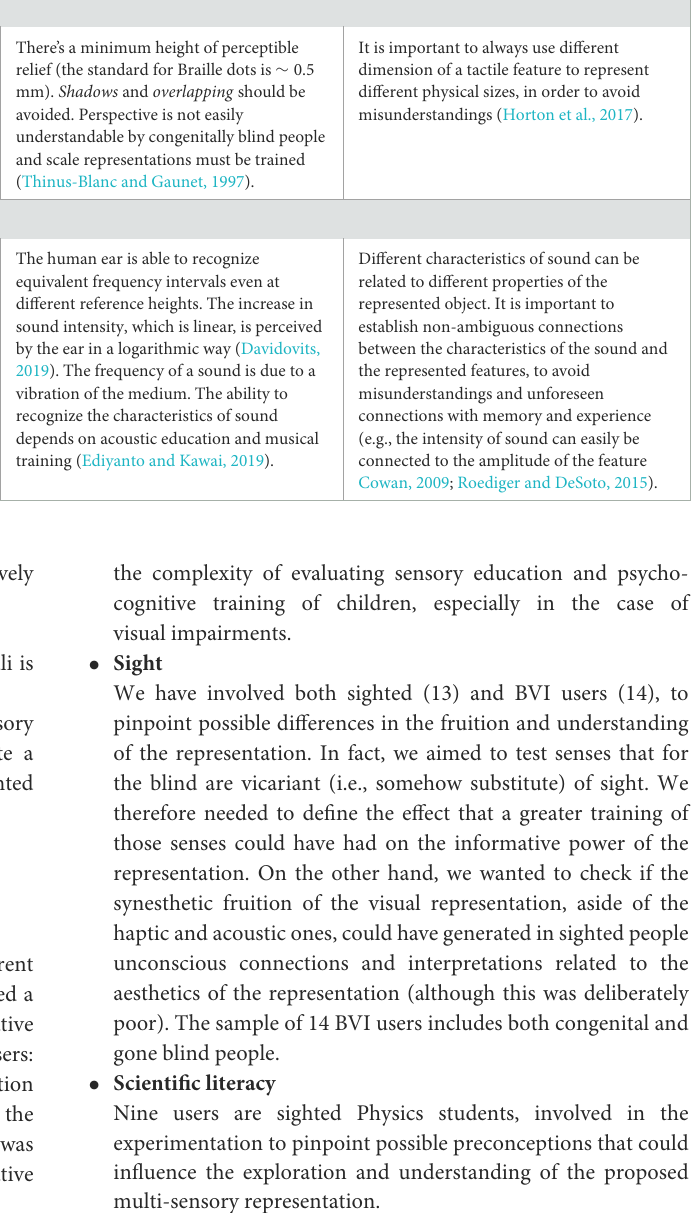
TABLE 1 Analysis of different sensory stimuli in terms of informative content, perception and level of arbitrariness. Sensory stimulus Visual Digital rendering of images in false